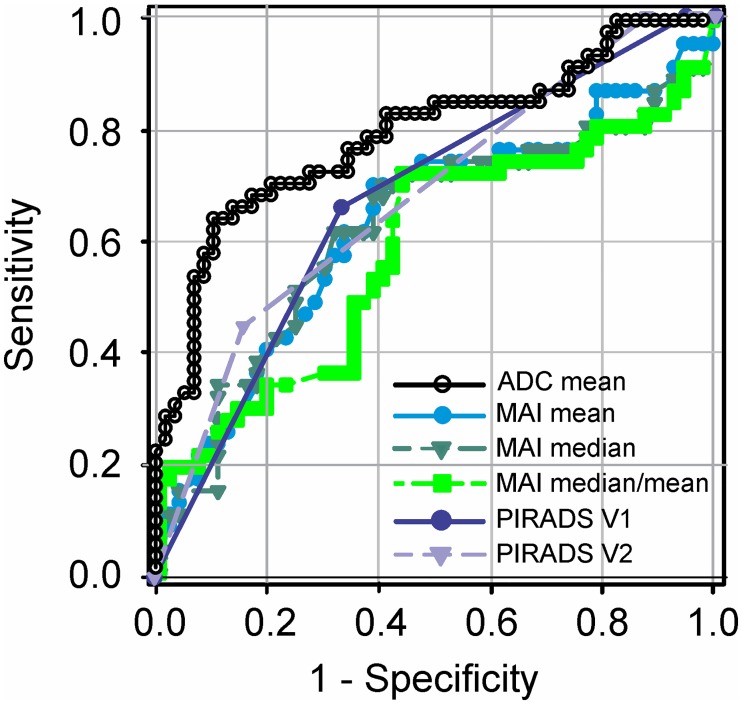
Receiver operating characteristic (ROC) trade-off curve for ADC, MAI and PI-RADS.ADC mean (black), MAI median (dark green), MAI mean (light blue) and MAI median/mean ratio (green). MAI is compared with the ADC performance alone and with the observer´s performance according to PI-RADS™ v1 (dark blue) and PI-RADS™ v2 (violet). The area under the curve (AUC) is 0.64±0.057 (mean, SEM) with 95% CI 0.53–0.75 and P 0.02 for MAI mean, 0.63±0.058 with 95% CI 0.52–0.74 and P 0.02 for MAI median and 0.59±0.058 with 95% CI 0.47–0.70 and P 0.13 for the MAI median/mean ratio. Corresponding values for the mean ADC lesion value are AUC 0.79±0.05 with 95% CI 0.70–0.88, P < 0.0001. Observer´s performance for PI-RADS™ v1 was AUC 0.67±0.05 with CI 0.58–0.76, P 0.003 and for PI-RADS™ v2 AUC 0.68±0.04 with CI 0.59–0.76, P 0.002. N malignant/benign cores 47/57. MAI and PI-RADS (v1, v2) reveal comparable performances in malignancy detection, P 0.60 for MAI vs PI-RADS v1 and P 0.53 for MAI vs PI-RADS v2, chi-squared test. ADC is superior to MAI in malignancy prediction, P 0.04, chi-squared test.